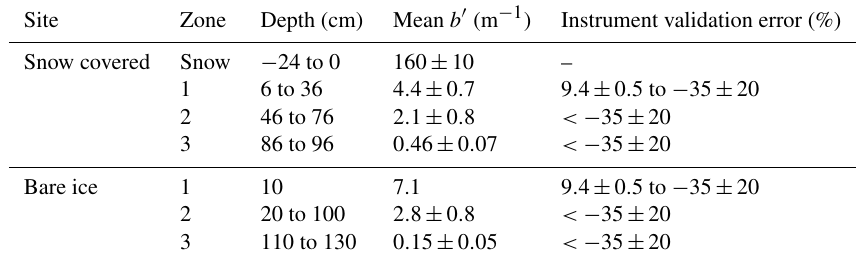
Table 3. Summary of mean b for the different ice and snow zones of both sampling sites and the corresponding instrument validation error e . Zones were separated at depth where we observed significant changes in b . The corresponding e was based on the validation with microsphere solutions. Site Zone Depth (cm) Mean b (cid:48) (m − 1 ) Instrument validation error (%) Snow covered Snow − 24 to 0 160 ± 10 – 1 6 to